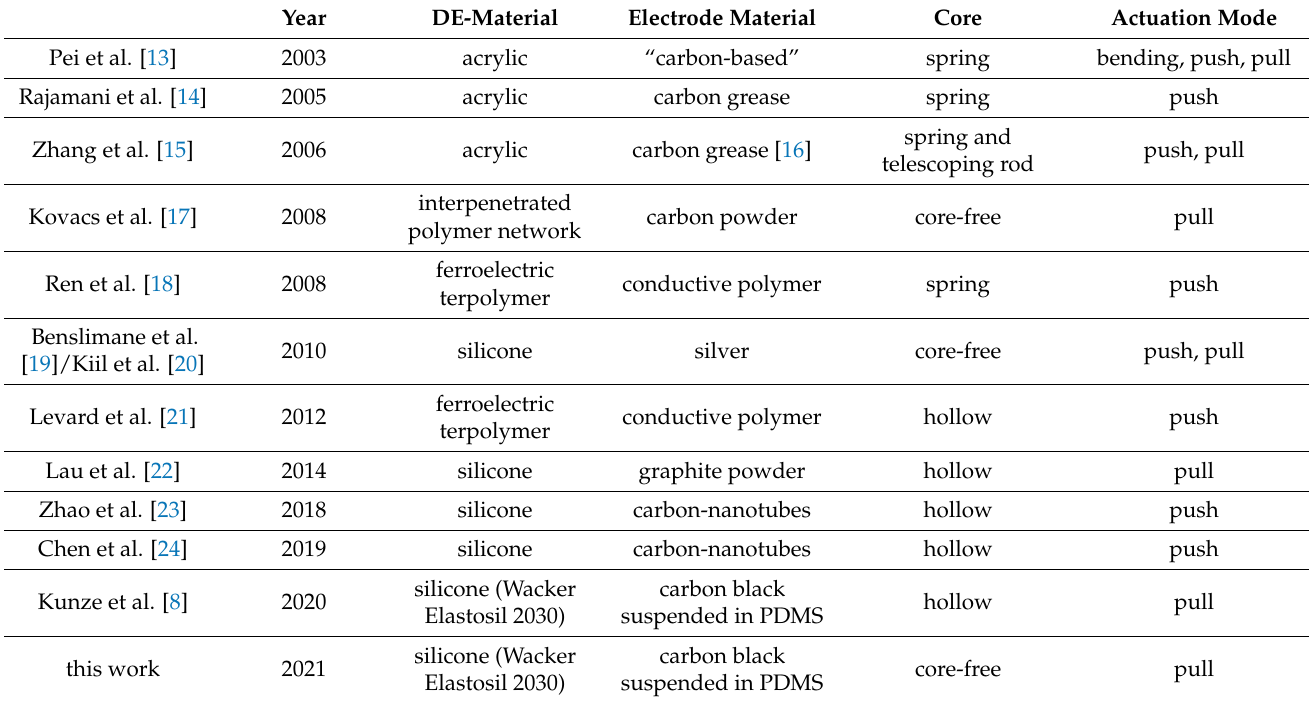
Table 1. Overview of existing works on rolled